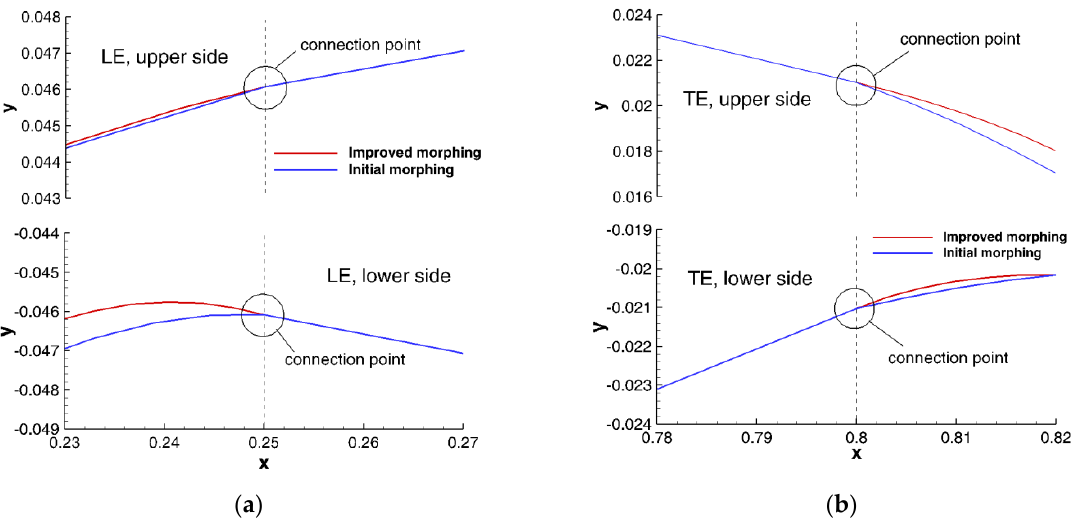
Figure 8. Improvement on the continuity of the optimized PSO airfoil geometry at the connection points between the morphing and the undeformed parts. ( a ) Focus on the connection points of the LE region. ( b ) Focus on the connection points of the TE region.